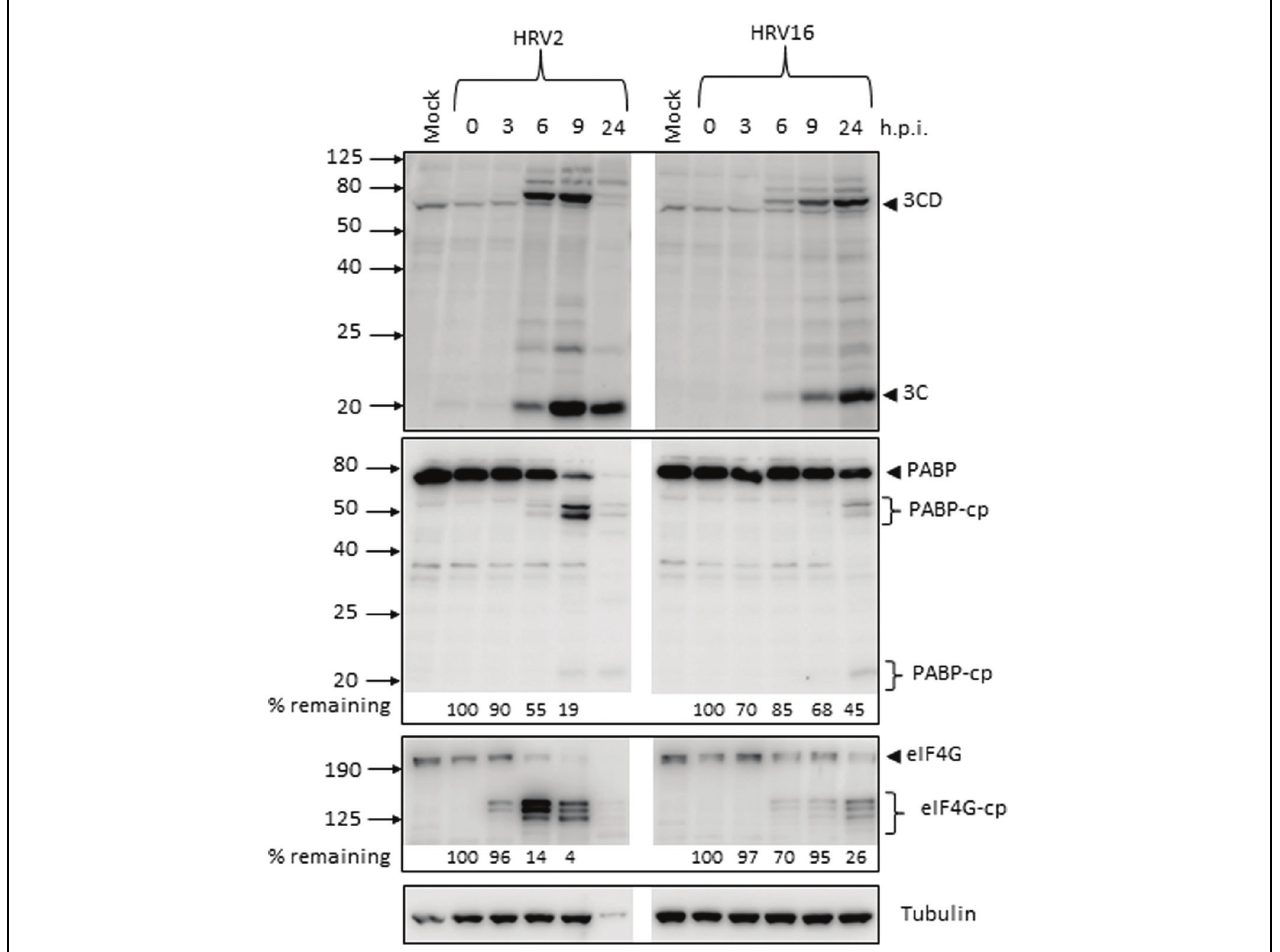
FIGURE 1 | Active proteases are produced at different times after infection with human rhinovirus 2 or 16 (HRV2 or HRV16). Ohio-HeLa cells were infected without (mock) or with HRV2 or HRV16 (MOI of 1) and cells lysed using RIPA buffer containing protease and phosphatase inhibitors at the time points shown. Cell lysates were subjected to SDS-PAGE on 4–20% gradient gels (for anti-3C detection) or 10% gels (remaining antibodies) and Western analysis using the indicated primary antibodies/horseradish peroxidise- conjugated secondary antibodies and enhanced chemiluminescence (Perkin